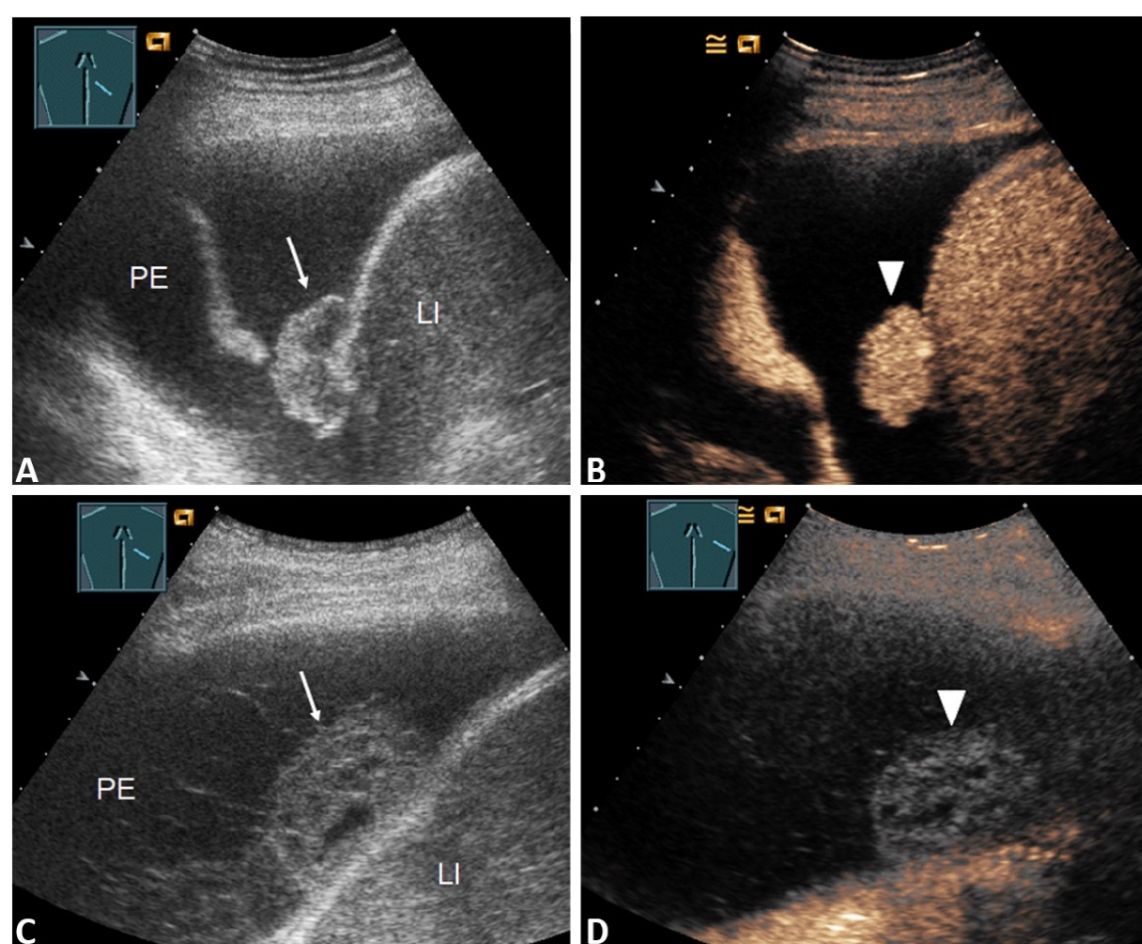
Figure 2. ( A ) 59-year-old patient with a right-sided PE. The effusion cytology was negative. B-TUS shows conspicuous nodular pleural thickening (arrow); ( B ) In the CEUS images, the nodular pleural thickening shows marked enhancement, such as in metastasis (stick). The final diagnosis was a malignant PE based on histologically confirmed pulmonary sarcoma. LI = Liver. ( C ) 64-year-old patient with fever, dyspnea, and a right PE. Effusion cytology was negative. B-US shows a septated effusion with a nodular formation on the diaphragm (arrow); ( D ) CEUS shows nodular pleural thickening with no enhancement, similar to fibrin bodies (sticks). The final diagnosis was a benign parapneumonic PE. LI =